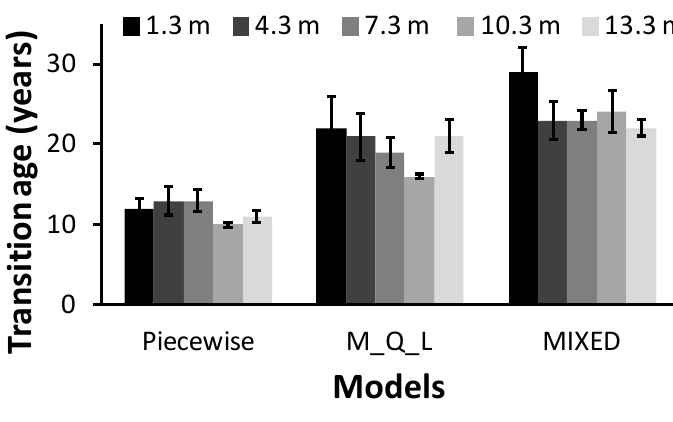
Figure 4. Longitudinal patterns of variation in transition age (years) with tree height (m) using the piecewise, maximum-quadratic-linear (M_Q_L), and MIXED models. Bars indicate standard errors.